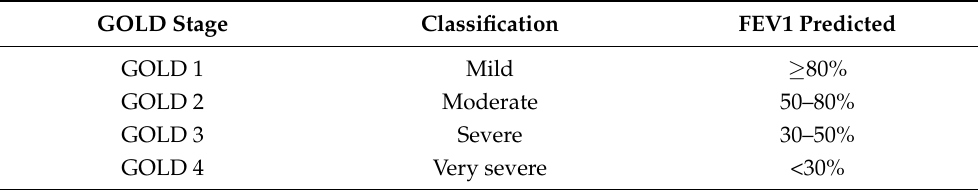
Table 3. COPD classification and